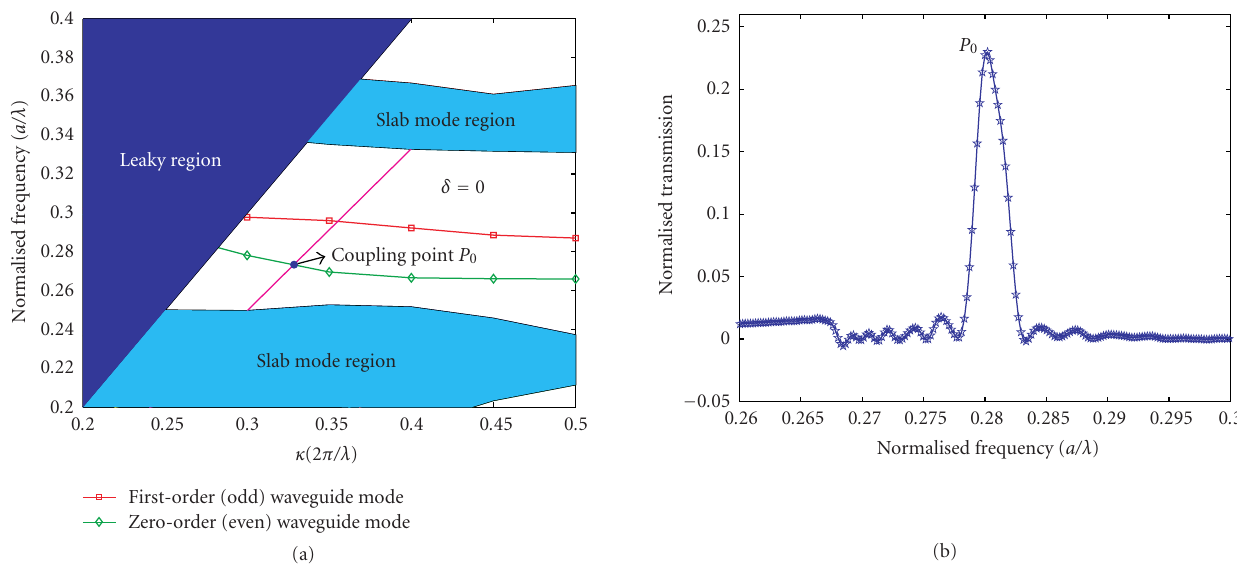
Figure 2: (a) Band diagram of PCSW 0 . The blue curve with diamond marker shows the zero-order even PCSW 0 mode. The coupling point is indicated as the blue dot P . Due to modal and structural symmetry, SiO 2 -Wr mode will not couple with the first-order odd mode of PSCW 0 (red curve with square marker). (b) Normalised power transmission in PSCW 0 over coupling distance of 50 lattice constants.